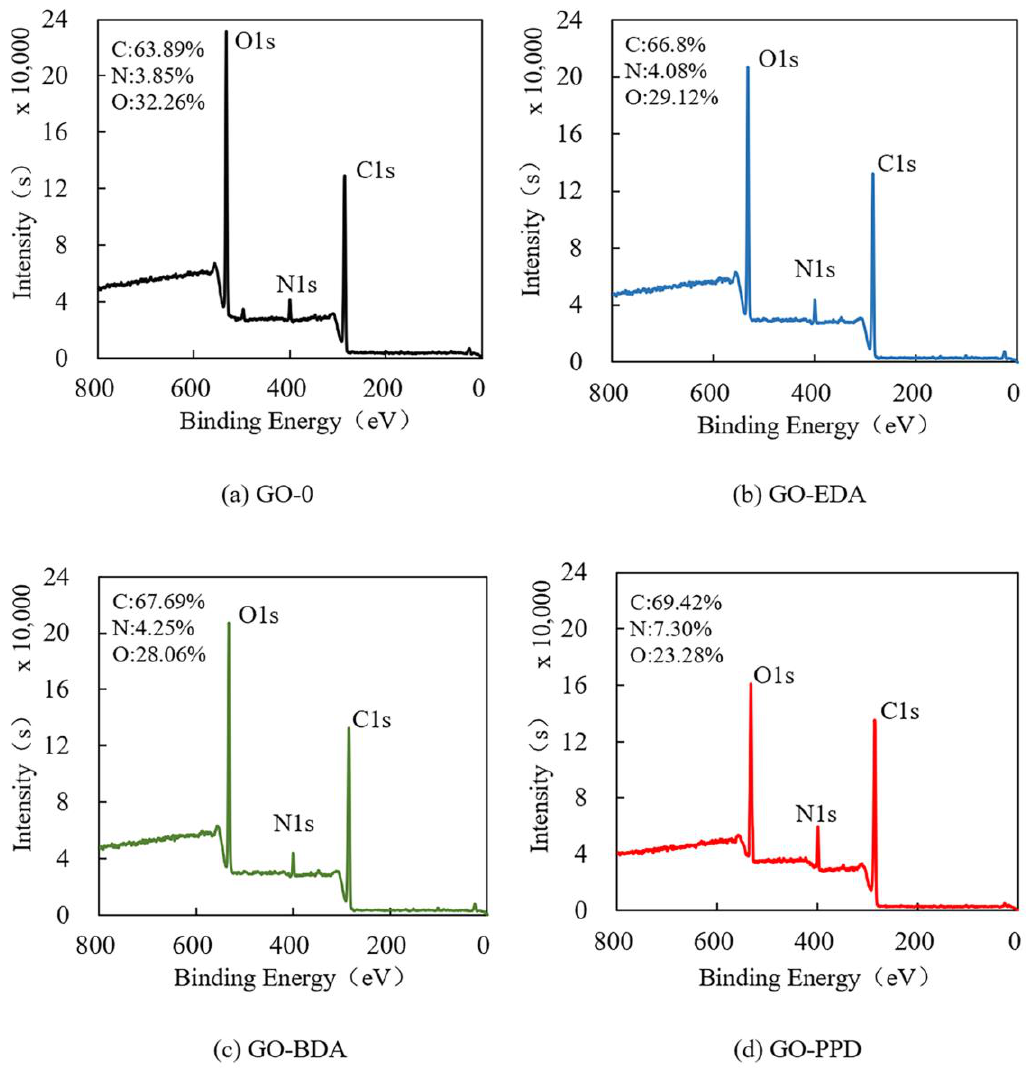
Figure 4. XPS full scan spectrum of: ( a ) GO-0, ( b ) GO-EDA, ( c ) GO-BDA, ( d ) GO-PPD.